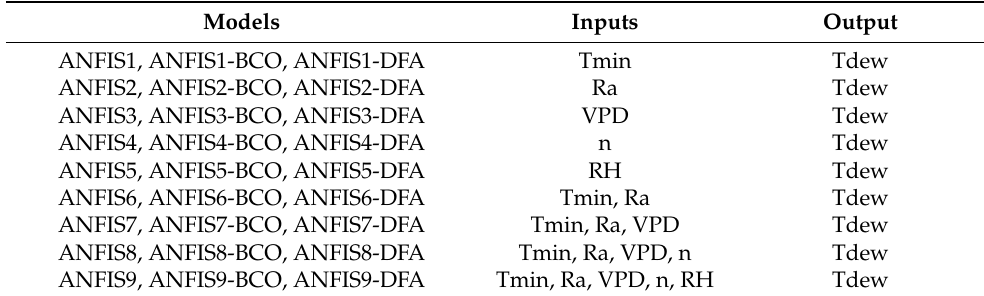
Figure 4. The radar graph of correlation coefficients of the Tdew and weather variables at the studied stations. Table 3. Input combinations defined to develop the classical and hybrid models.